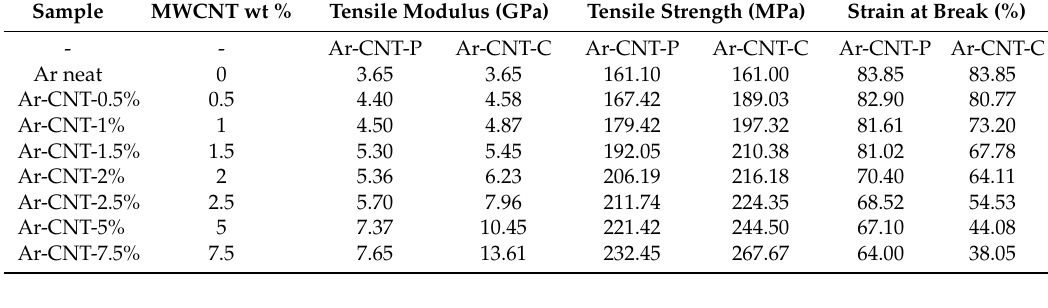
Figure 9. Stress vs strain curves of Ar-CNT-P ( A ) and AR-CNT-C ( B ) composite: CNT wt %: 0( ── ), 0.5 (   ), 1( ‥‥ ), 1.5 (     ), 2 (  ‥  ), 2.5 ( ̶ ̶ ), 5 (  ٠  ٠ ), 7.5 (    ).